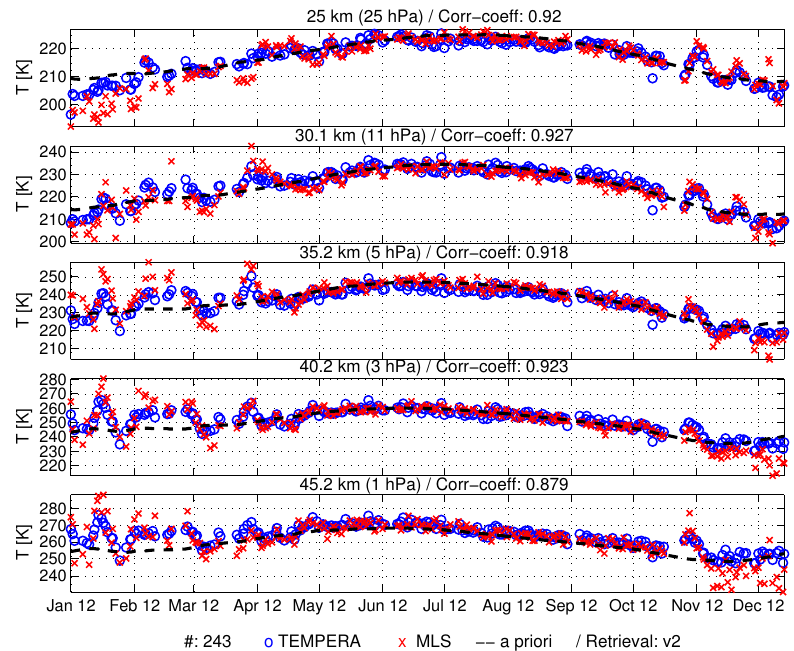
Fig. 18. Time series (243 profiles) of stratospheric temperature profiles from TEMPERA (blue) compared with MLS data (red, regridded to TEMPERA grid) for five different altitude levels. The black dashed line is the a-priori.